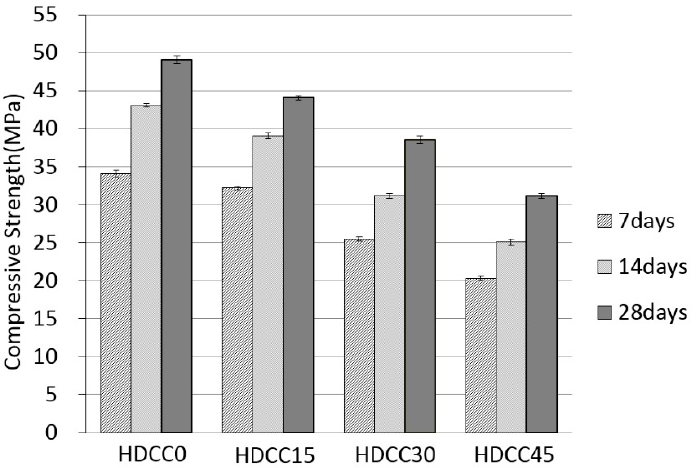
Figure 3. Compressive strength of highly ductile cement composites (HDCCs).